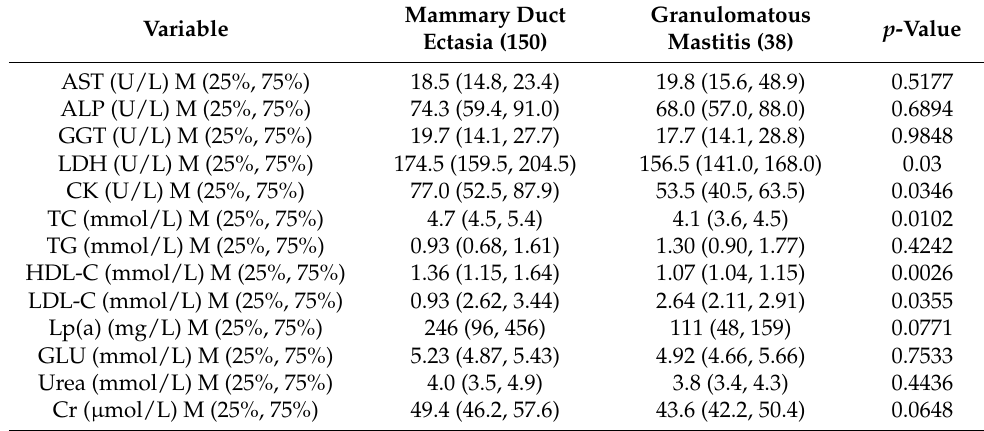
Table 4. Biomedical indicators of non-puerperal mastitis